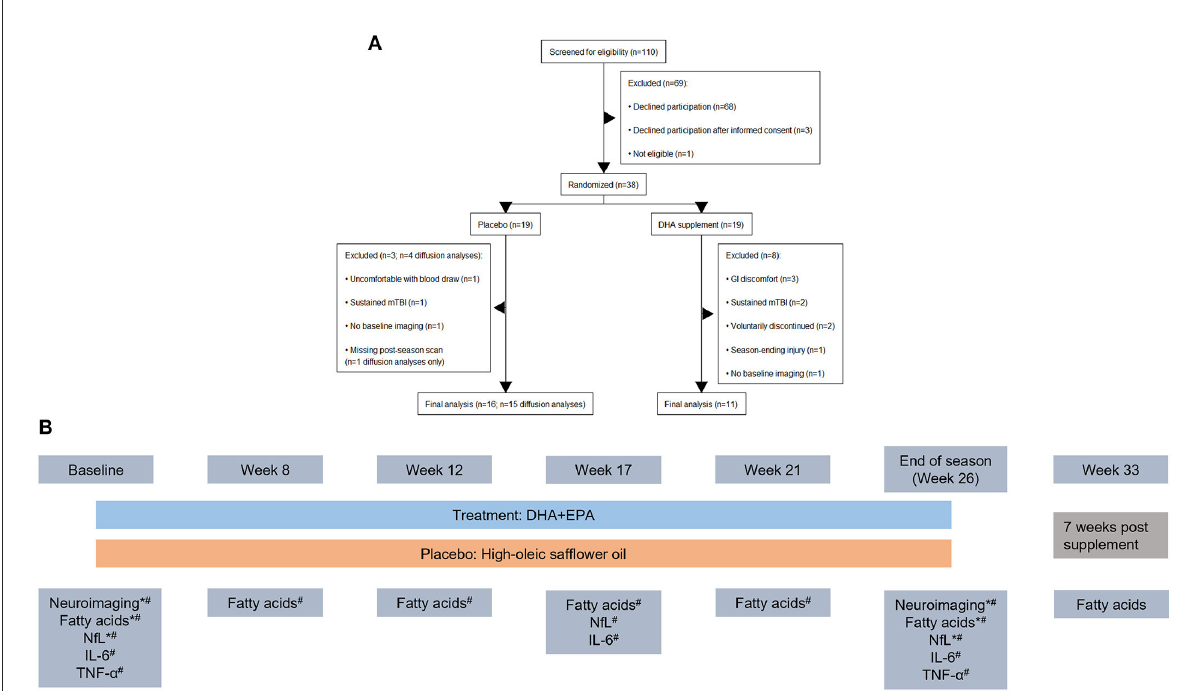
FIGURE1 CONSORT diagram outlining participant flow through the study and study design. (A) Nineteen individuals were initially randomized to each arm of the study. After exclusions for study withdrawal and imaging completeness, a total of 27 individuals were analyzed for volumetric and functional connectivity outcomes and 26 individuals were analyzed for diffusion weighted imaging outcomes. (B) Study design schematic including time points for MRI and blood draws during the study. Outcomes reported in the present manuscript are denoted with a “*” and those reported in Mullins et al. (43) are denoted with a “#”. Blood-based biomarkers were collected together. Neuroimaging was collected in a 3-week (baseline) and 2-week (end of season) window around the blood